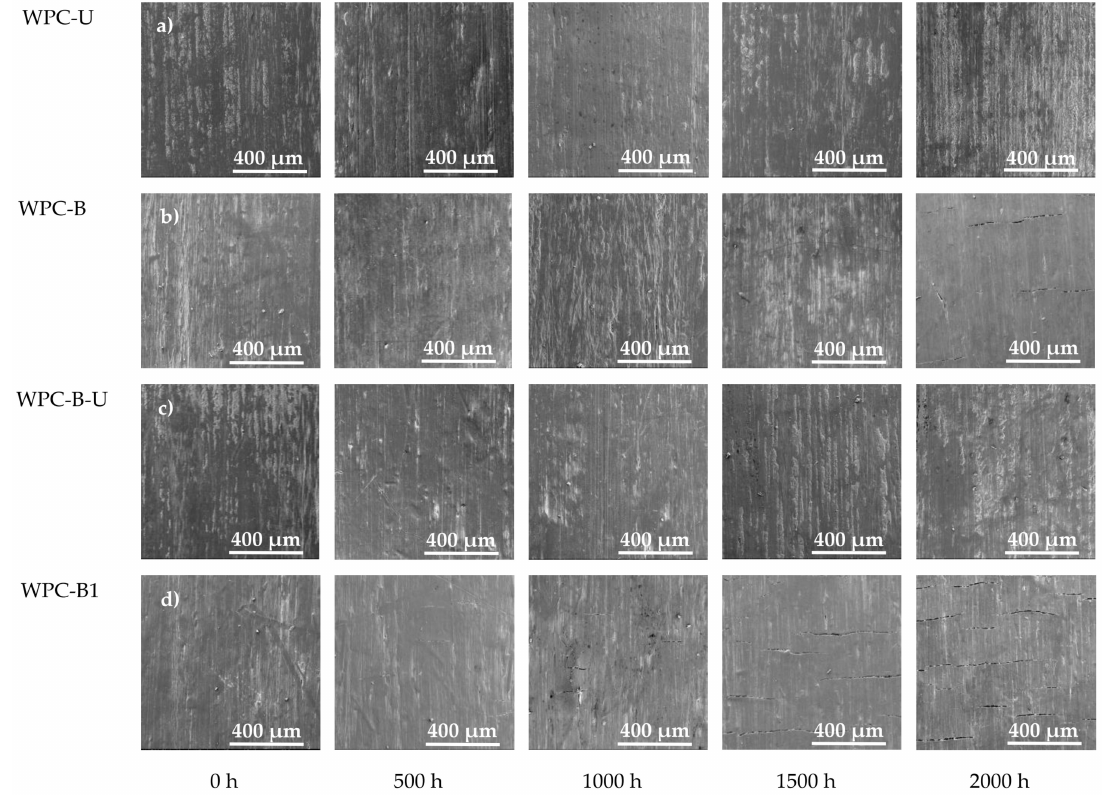
Figure 4. Scanning electron microscopy (SEM) micrographs (100 × ) of composites at different times after accelerated UV weathering for 0, 500, 1000, 1500, and 2000 h.